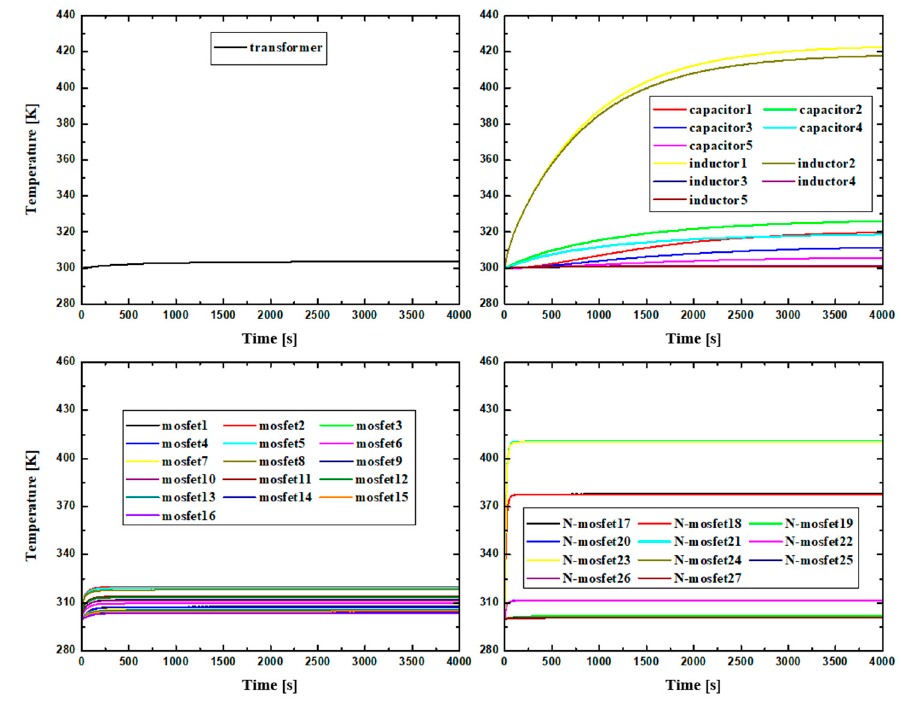
Figure 9. Temperature profile of the module for a cooling water flow rate of 6 LPM in Operating Mode 1.